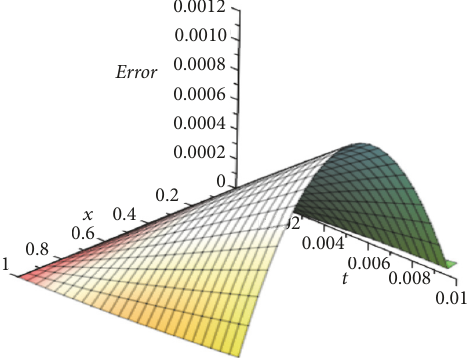
Figure 6: Absolute error for (33) using VIMB when n=m=2 and 𝑡 = 0.01